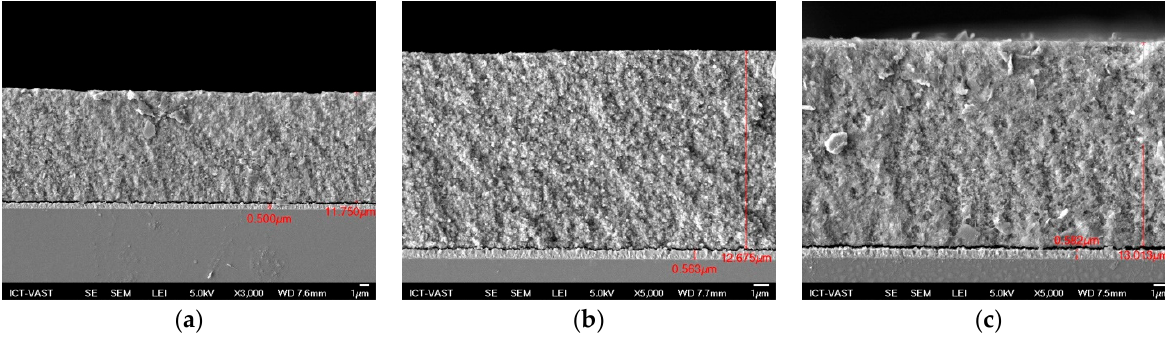
Figure 2. The FE-SEM of ( a ) TiO 2 /CdS/Cd x Cu 1 − x Se, ( b ) TiO 2 /CdS/Cd x Mn 1 − x Se, and ( c ) TiO 2 /CdS/Cd x Ag 2 − 2x Se films.